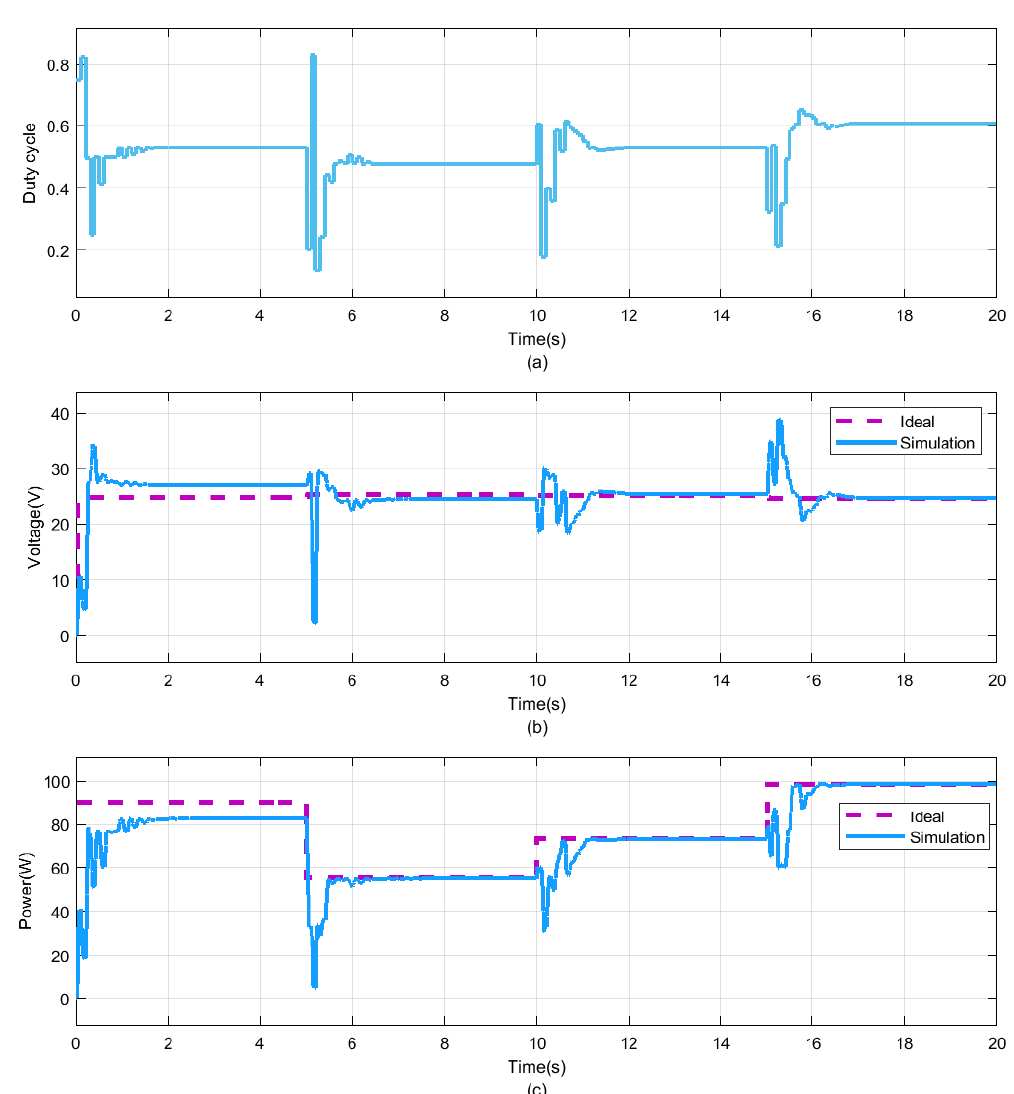
Figure 16. Simulation results under different sets of partially shading and Np = 2 given by the Improved Particle Swarm Optimization (IPSO) method: ( a ) Duty cycle, ( b ) Voltage, and ( c )